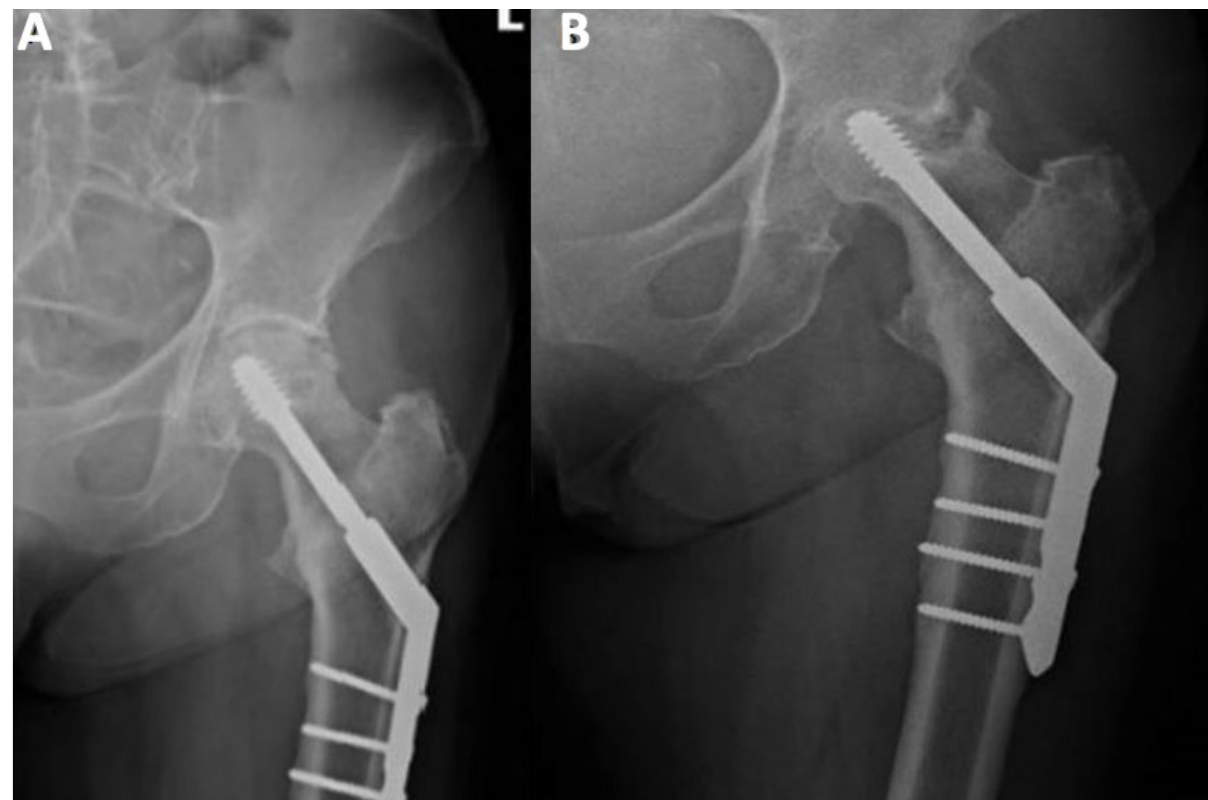
Figure 2. Posteroanterior view of internal fixation of left femoral neck fracture using the dynamic hip screw. ( A ) Posteroanterior view directly after the procedure; ( B ) posteroanterior view during control 15 weeks after the procedure, prominent necrosis of left femoral head.